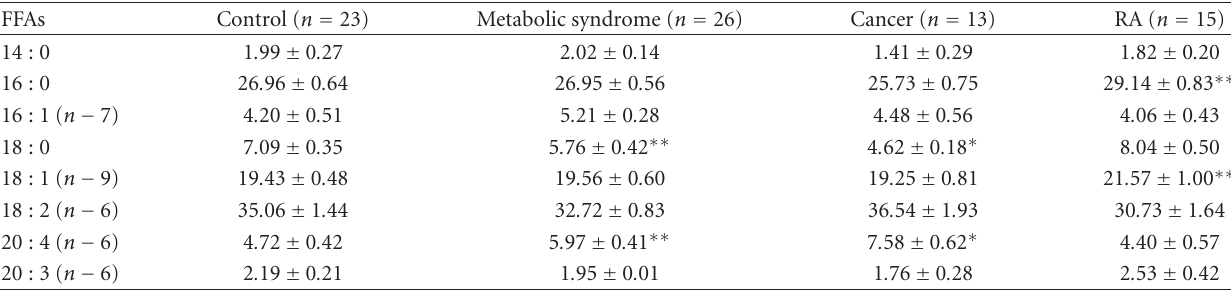
Table 4: The amounts of major free fatty acids (FFAs) as % of total amount in plasma of patients with metabolic syndrome, RA, and cancer. Results were expressed as means ± SEM (compared to control, ∗ P < . 001, ∗∗ P < . 05).